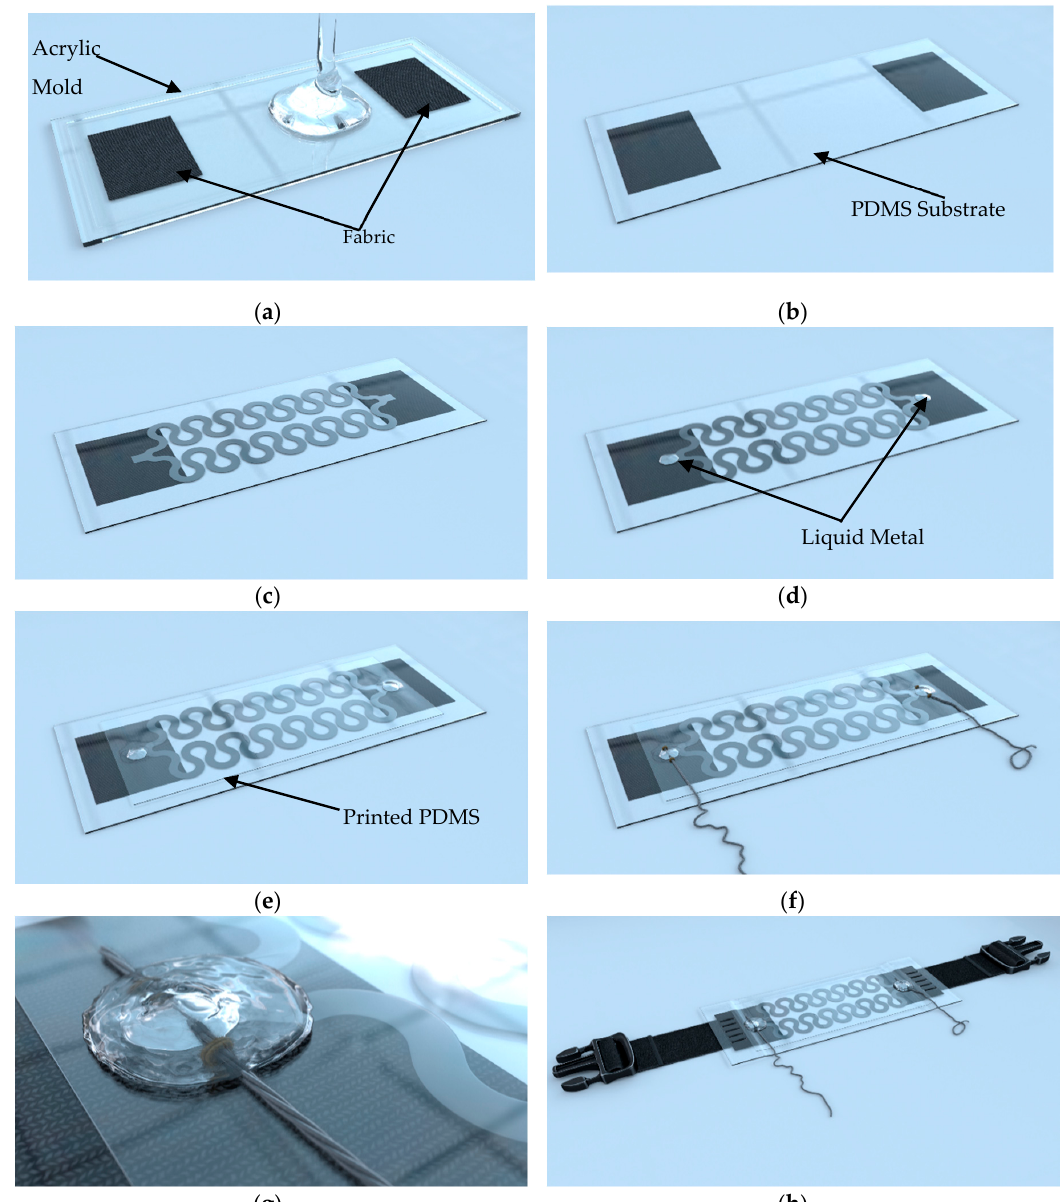
Figure 4. The fabrication process of the respiratory rate sensors: ( a ) pouring the PDMS mixture on the fabric; ( b ) cured PDMS sample with embedded fabrics; ( c ) conductive pattern deposition using the inkjet printer; ( d ) pouring small drops of liquid metal at the pattern’s pads; ( e ) coating the circuit with 10 layers of PDMS; ( f ) sewing the conductive threads over the liquid metal; ( g ) developing PDMS incubators for the liquid metal and ( h ) sewing the sensor to the fabric belt. It should be noted that the presented pattern in the fabrication procedure here is just for demonstration.